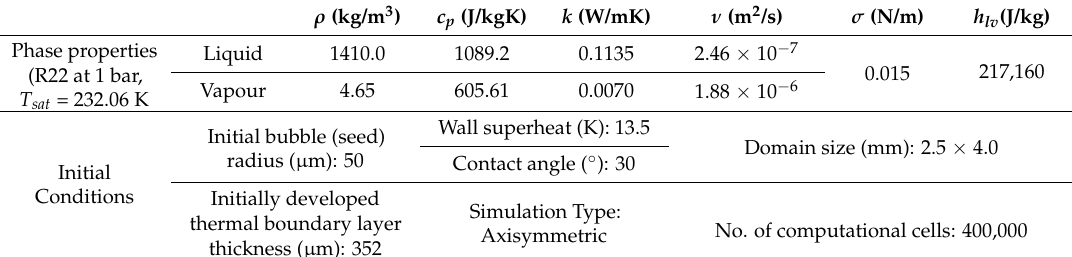
Table A2. Fluid properties and initial conditions (base case for R22, Series B–D).